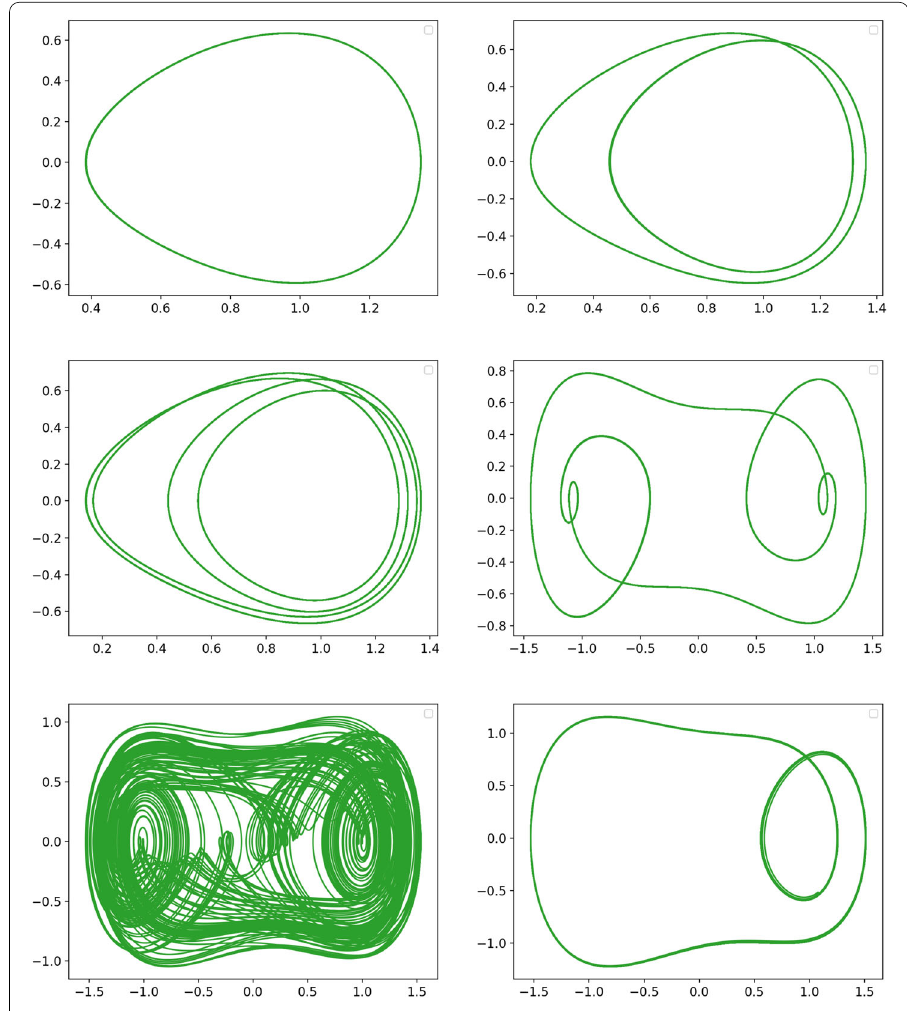
Fig. 14 Duffing equation: phase portraits. From left to right and from top to bottom, c = 0 . 20, 0 . 28, 0 . 29, 0 . 37, 0 . 50, 0 .